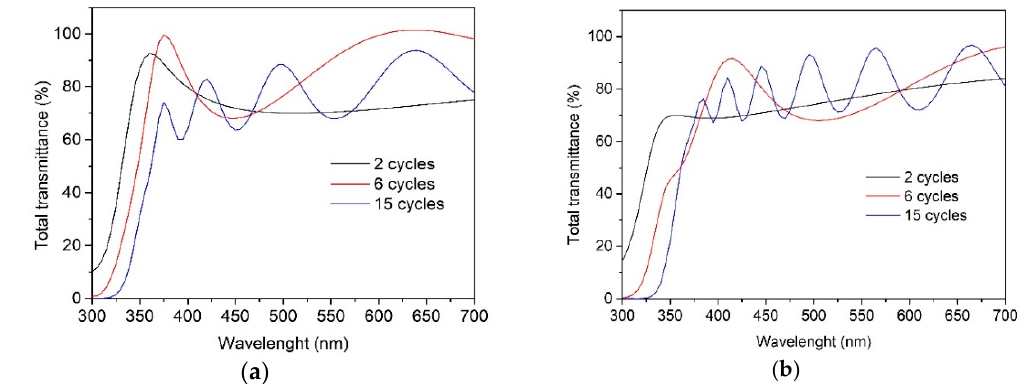
Figure 4. Total transmittance spectra of the TiO 2 films deposited from solution with the concentrations of ( a ) 0.1 M and ( b ) 0.2 M onto borosilicate substrate and varying the number of spray cycles from 2 to 15.